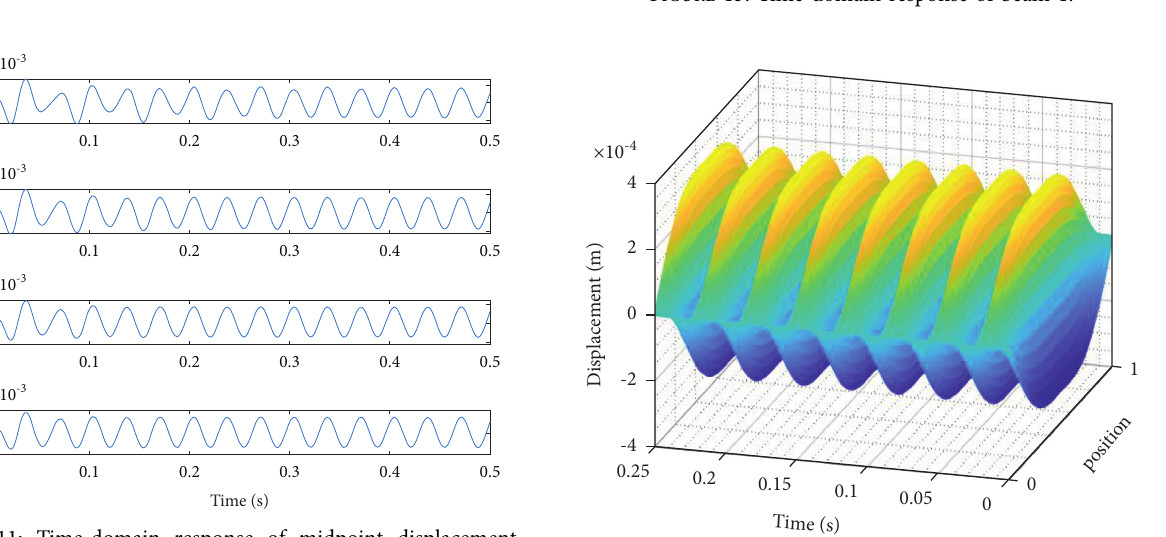
Figure 13: Time-domain response of beam 1.